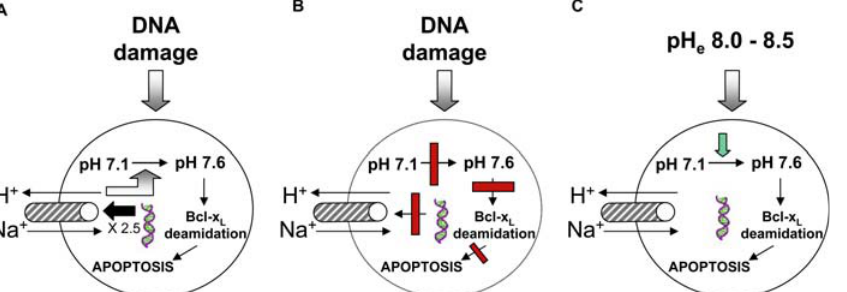
Figure 7. Models Illustrating the Linkage Between DNA Damage, the NHE-1 Antiport, Alkalinisation, Bcl-x L Deamidation, and Apoptosis in Wild-Type and Cancer Cells (A) In wild-type thymocytes,DNA damagecausesincreasedNHE-1 expressionand a consequent rise inintracellularpH,Bcl-x L deamidation, andapoptosis. (B) In pretumourigenic thymocytes expressing an OTK, the DNA damage–induced rise in NHE-1 expression is blocked, preventing alkalinisation, Bcl-x L deamidation, and apoptosis. (C) Enforced alkalinisation of murine tumour cells, or human B-CLL cells, causes Bcl-x L deamidation and subsequent apoptosis, even in the absence of external genotoxic attack.